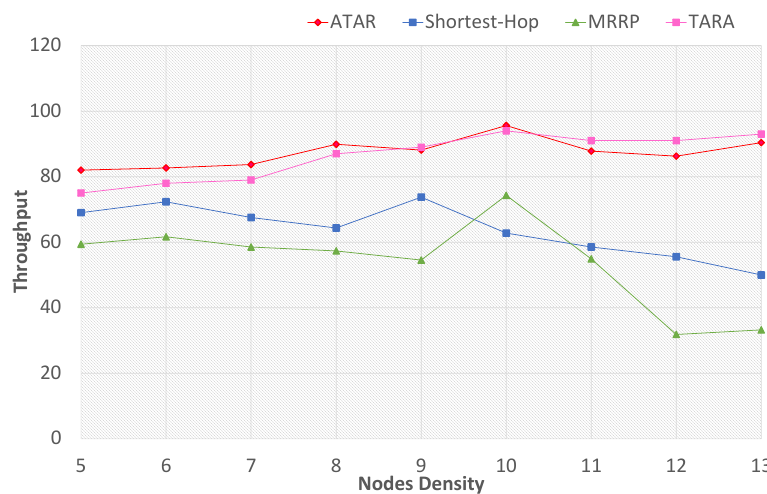
Figure 19. Average throughput with different nodes density at simulation time = 1000